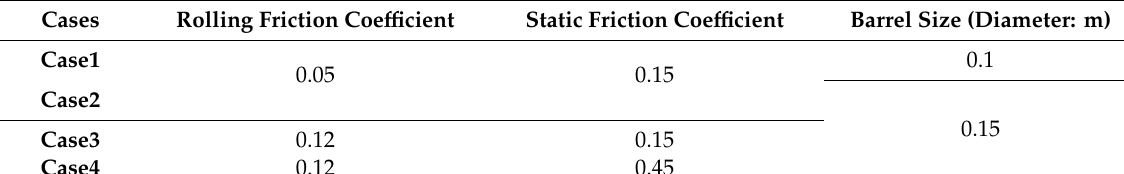
Table 3. Di ff erent cases studied by the Lifting Method.